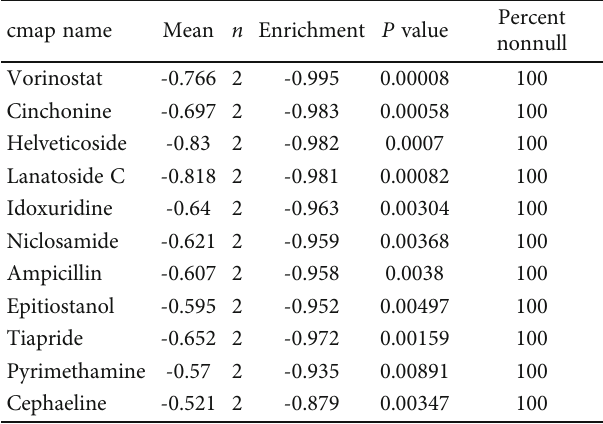
Figure 2: Volcano map showed the di ff erentially expressed PPAR- targeted genes (DEPPARGs). The red plots represented the upregulated genes, the blue plots represented the underregulated genes, and the black plots represented no statistically di ff erentially expressed genes with the criterion of FDR < 0 : 05 and ∣ log 2FC ∣ > 1 . FDR: false discovery rate; FC: fold change. Table 1: The 11 small-molecule drugs of CMP database